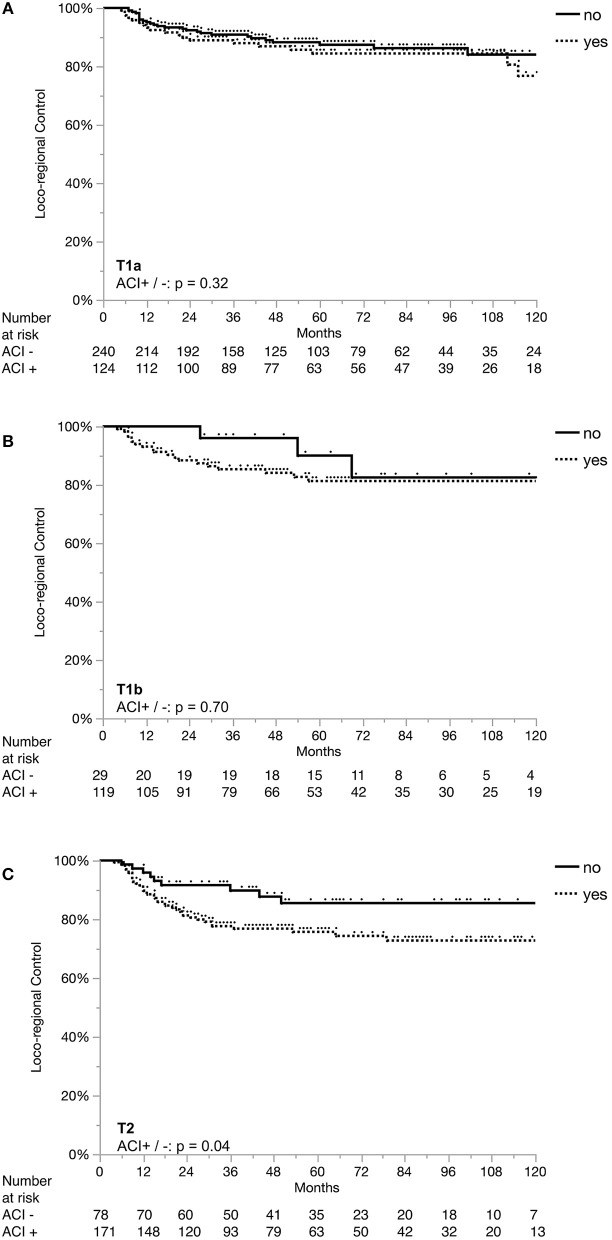
Loco-regional control separated by anterior commissure involvement in each stage. ACI, anterior commissure involvement; Loco-regional control in Stage T1a (A), in Stage T1b (B), and in Stage T2 (C).